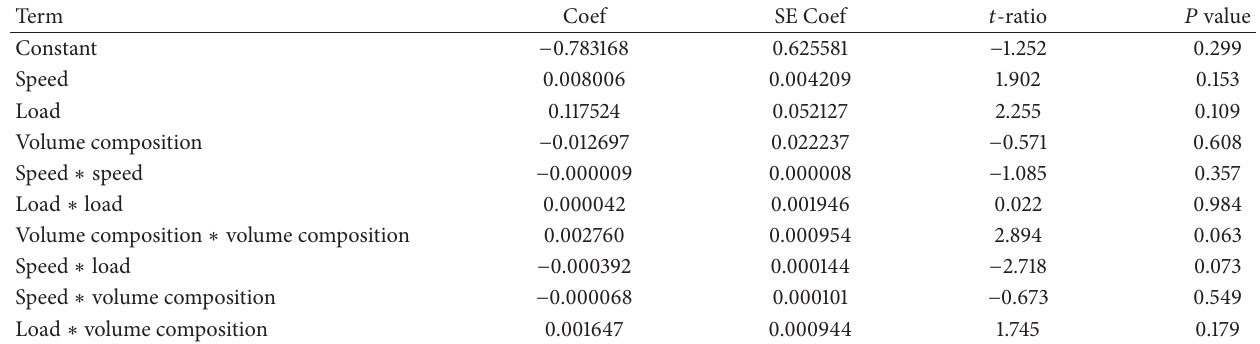
Table 10: Estimated regression coefficients for wear rate.